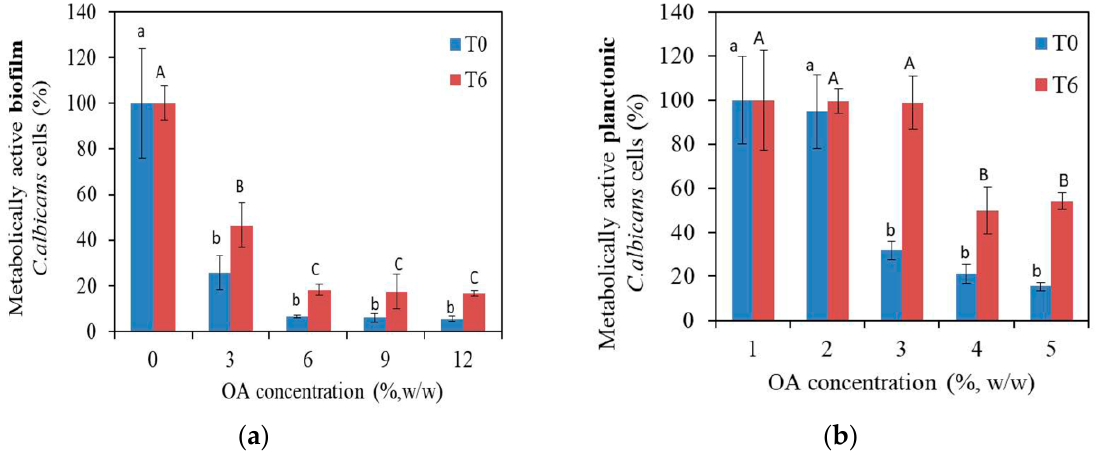
Figure 3. Metabolic activity of C. albicans cells on the surface of composites with 0, 3, 6, 9, and 12 wt% of oleic acid (OA) in Poly(Methyl Methacrylate), ( a ) in biofilm and ( b ) in the medium above composites in 2-time points: T0 and T6. Bars indicate the mean values and vertical lines standard deviations (SD). Different lowercase alphabetical letters above the columns show significant differences among the groups at T0 time ( p < 0.001, Tukey’s test). Different uppercase alphabetical letters above the columns show significant differences among the groups at T6 time ( p < 0.001, Tukey’s test). The results were presented as mean ± SD compared to control.